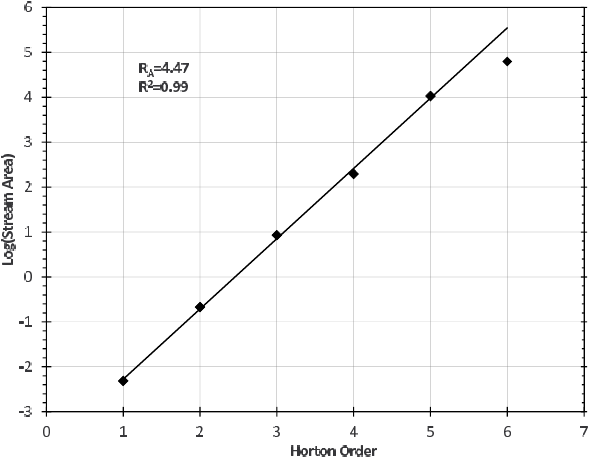
Figure 5. Horton plot for stream width (including orders 2, 3, and 4) for the Ashley river basin (McKerchar et al., 1998); results kindly provided by Mantilla (2014).